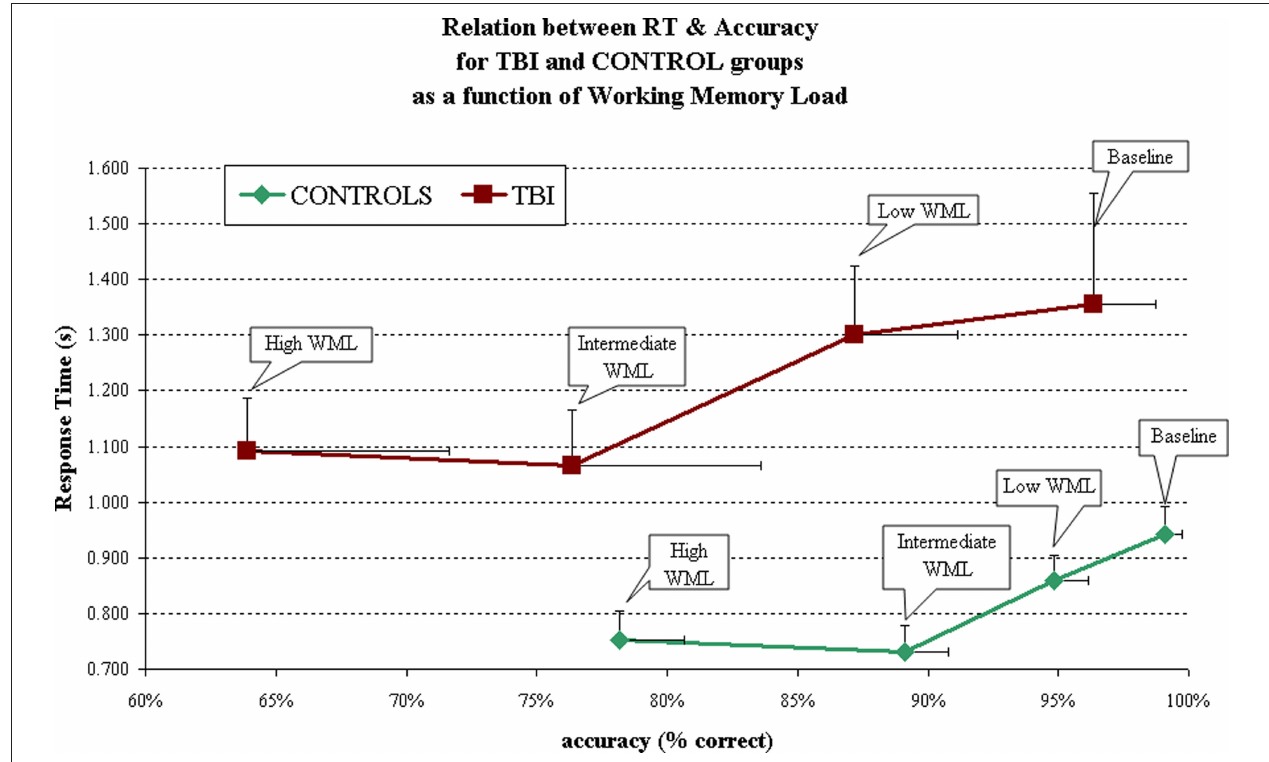
FIguRe 2 | Behavioral results for the cross-sectional study.